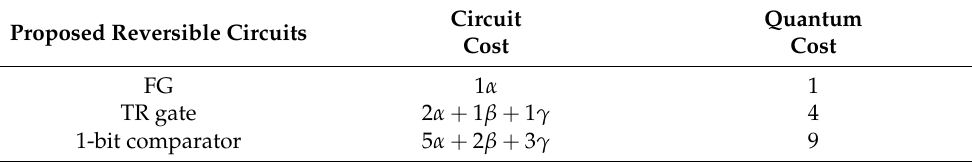
Table 6. Quantum cost for QCA layout the proposed reversible circuits.